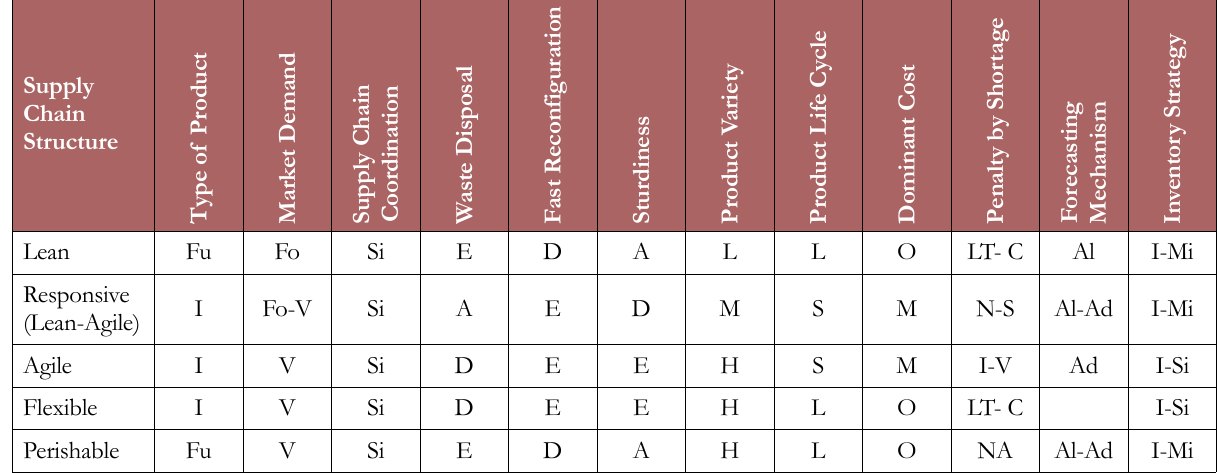
Table 1. Characteristics of the SC